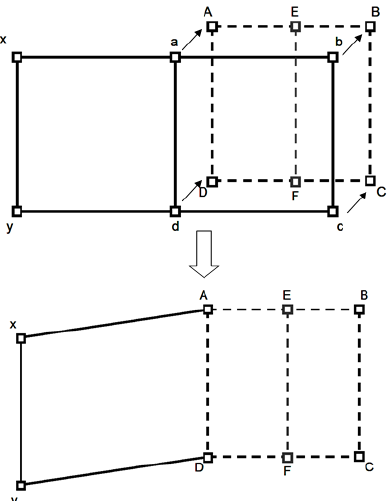
Figure 2. Cadastral boundaries (Solid Lines) and higher accuracy (Dashed Lines). Polygon xady is distorted if